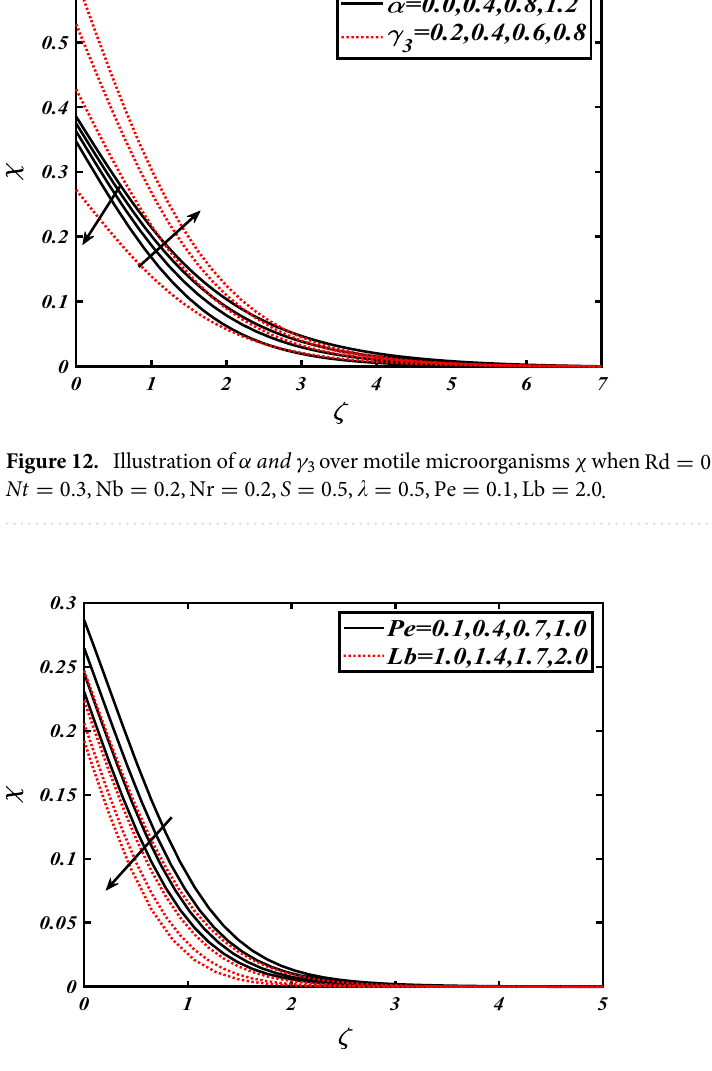
Figure 13. Illustration of Pe and Lb over motile microorganisms χ when Rd = 0.4, γ 2 = 0.3, γ 1 = 0.3, Nt = 0.3, Nb = 0.2, Nr = 0.2, S = 0.5, (cid:31) = 0.5